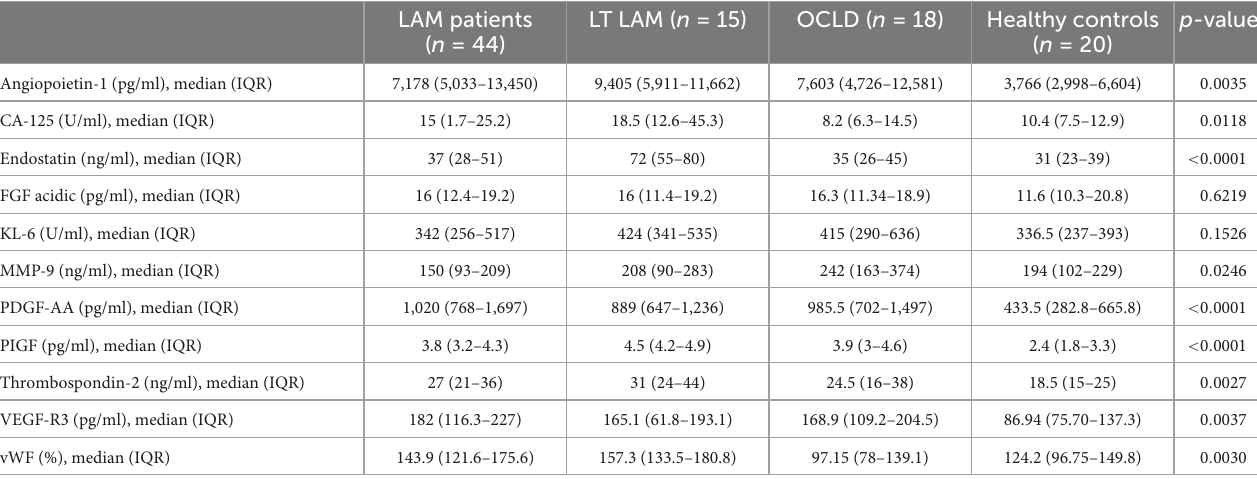
TABLE 2 Biomarker levels from LAM patients, QQLT LAM patients, OCLD and healthy controls.